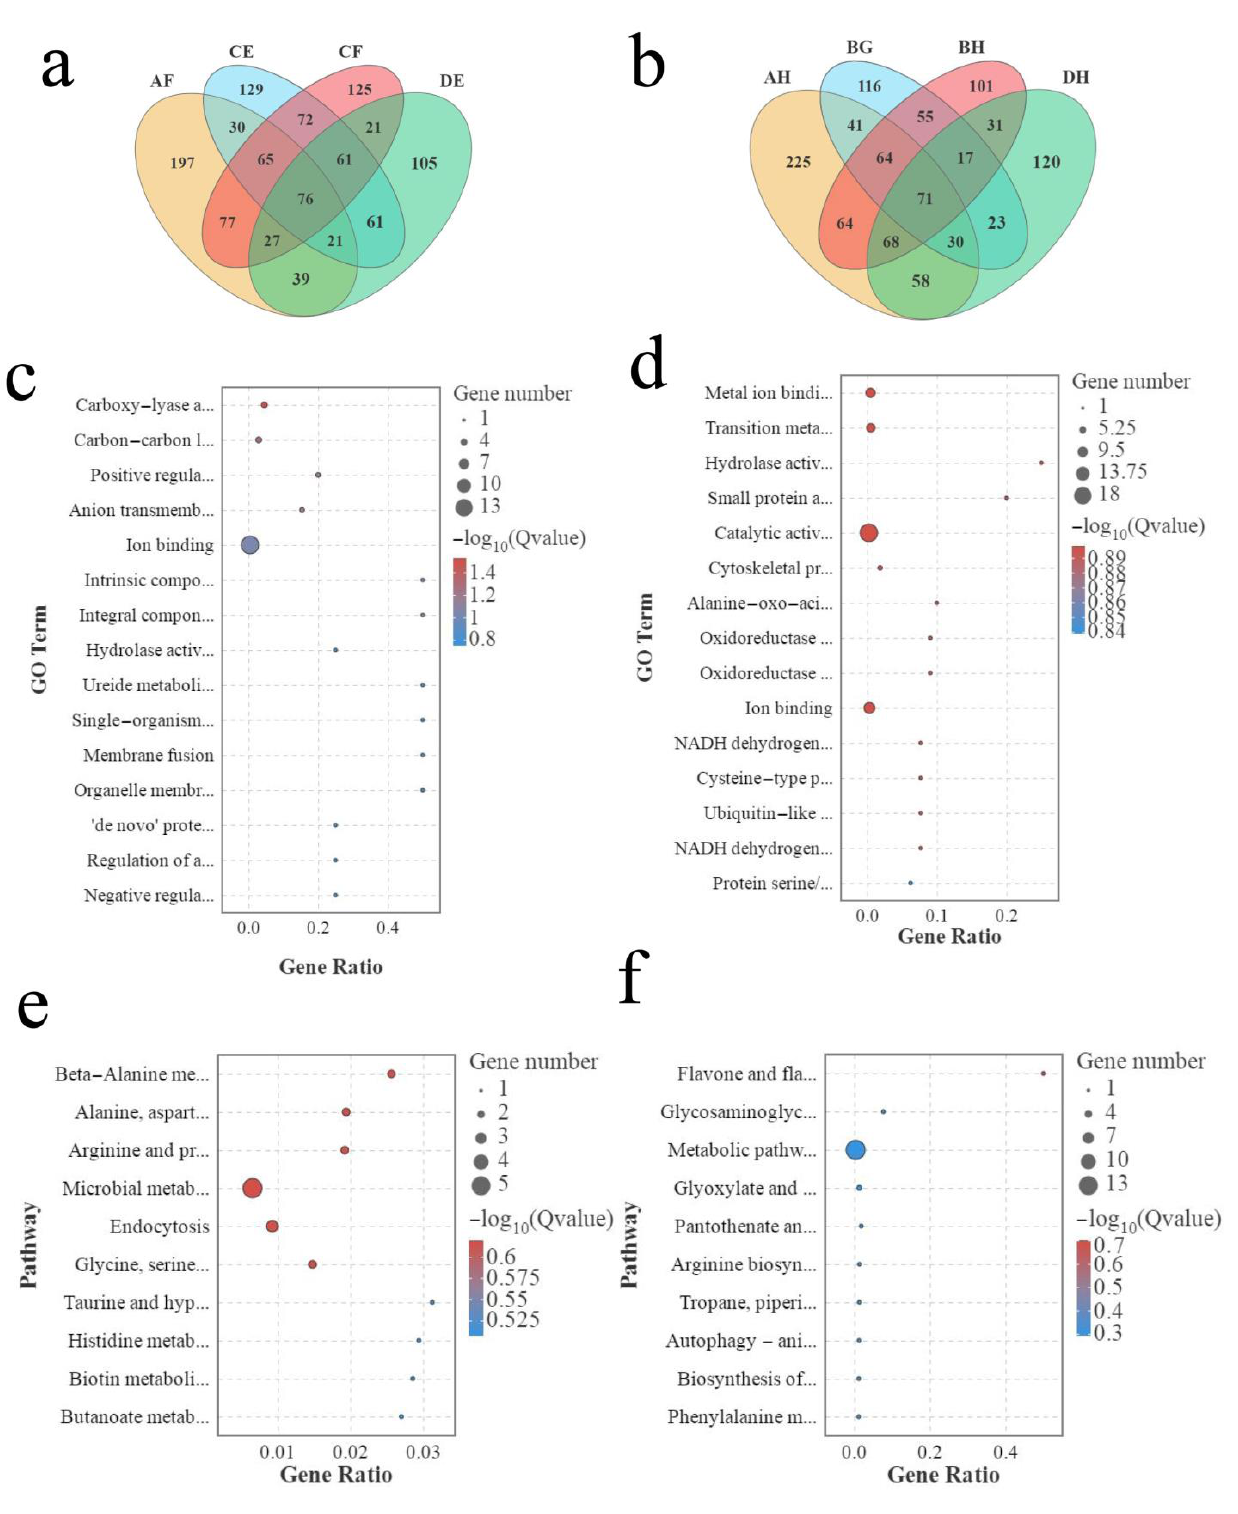
Figure 6. Analysis of different AS genes in strong heterosis combinations and weak heterosis combinations. ( a ) Venn map of different AS genes in strong heterosis combinations. ( b ) Venn map of different AS genes in weak heterosis combinations. ( c ) GO enrichment of different AS genes in strong heterosis combinations. ( d ) GO enrichment analysis of different AS genes in weak heterosis combinations. ( e ) KEGG enrichment analysis of different AS genes in strong heterosis combinations. ( f ) KEGG enrichment analysis of different AS genes in weak heterosis combinations.